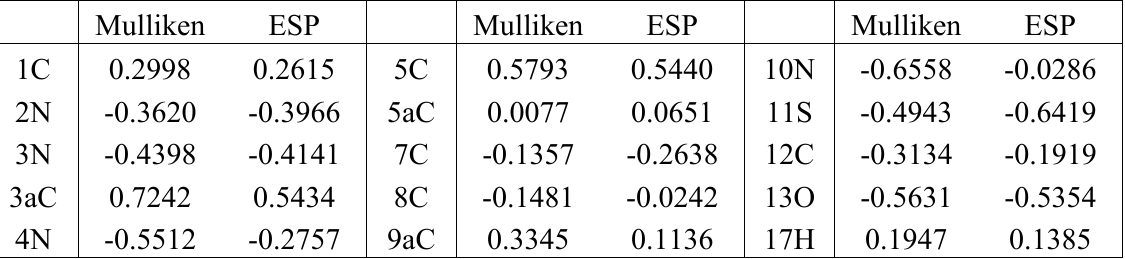
Table 2. The partial charge values of selected atoms in the anion form of 3